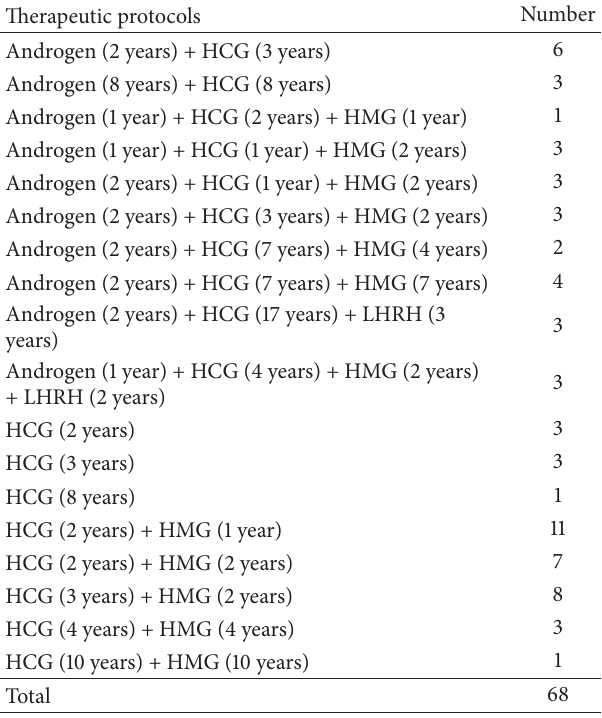
Table 1: Different therapeutic protocols that IHH patients